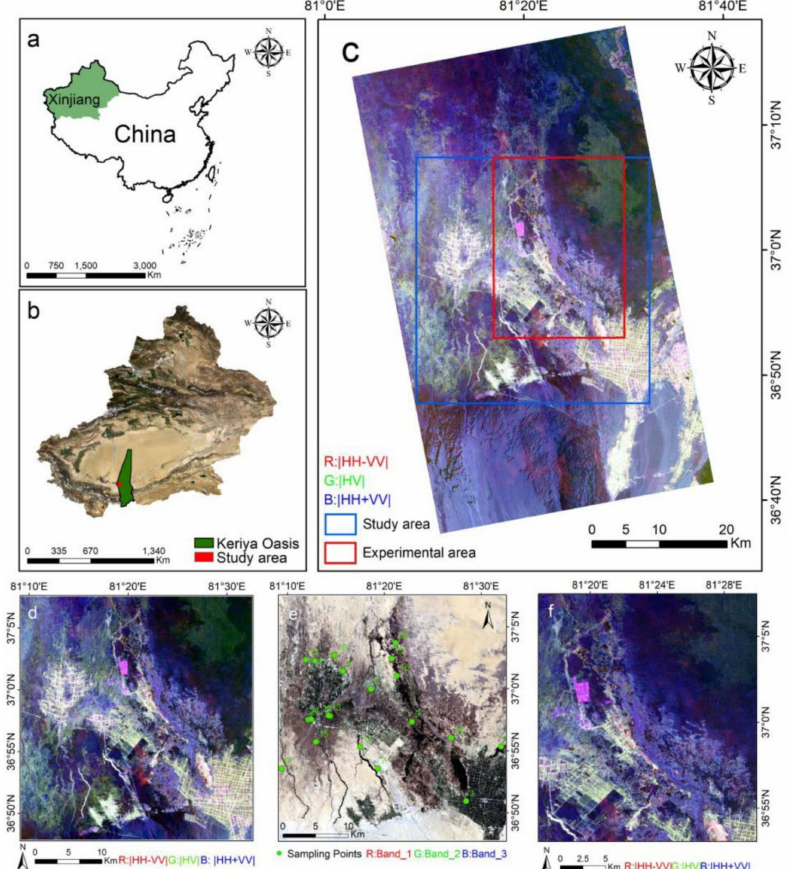
Figure 1. ( a ) Location of the study area on the overview map of China; ( b ) Xinjiang location; ( c ) the full phased array type L-band synthetic aperture radar (PALSAR-2) image; ( d ) the subset image covering the study area in Pauli decomposition with standard color-coding; ( e ) topographic map of sampling points of the study area; ( f ) typical land type in the experimental